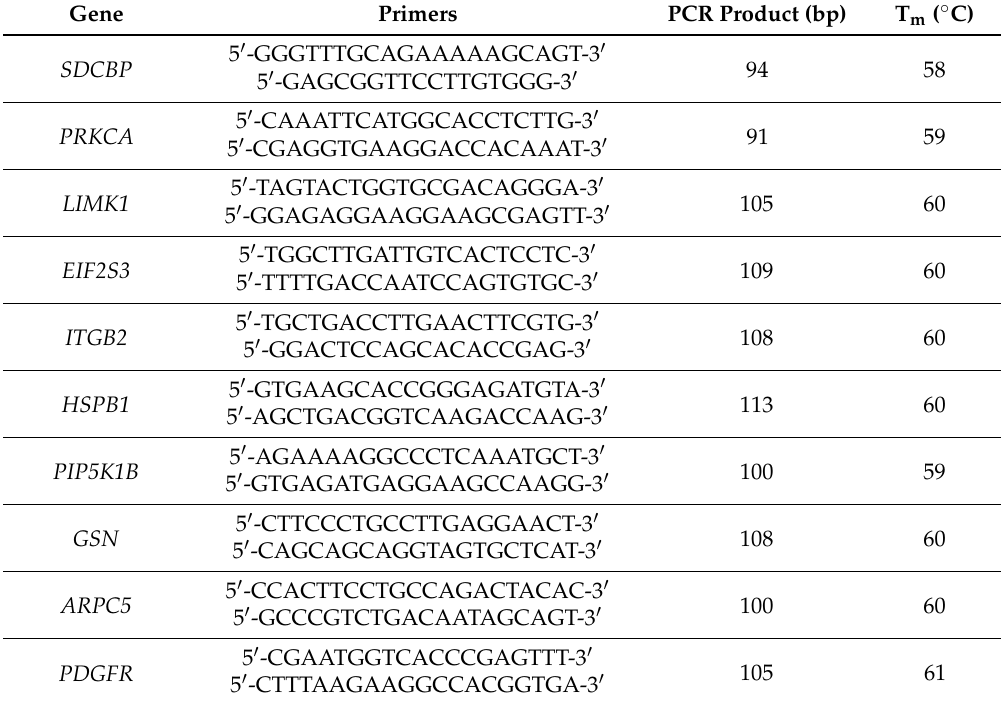
Table 5. Primers used in real-time PCR